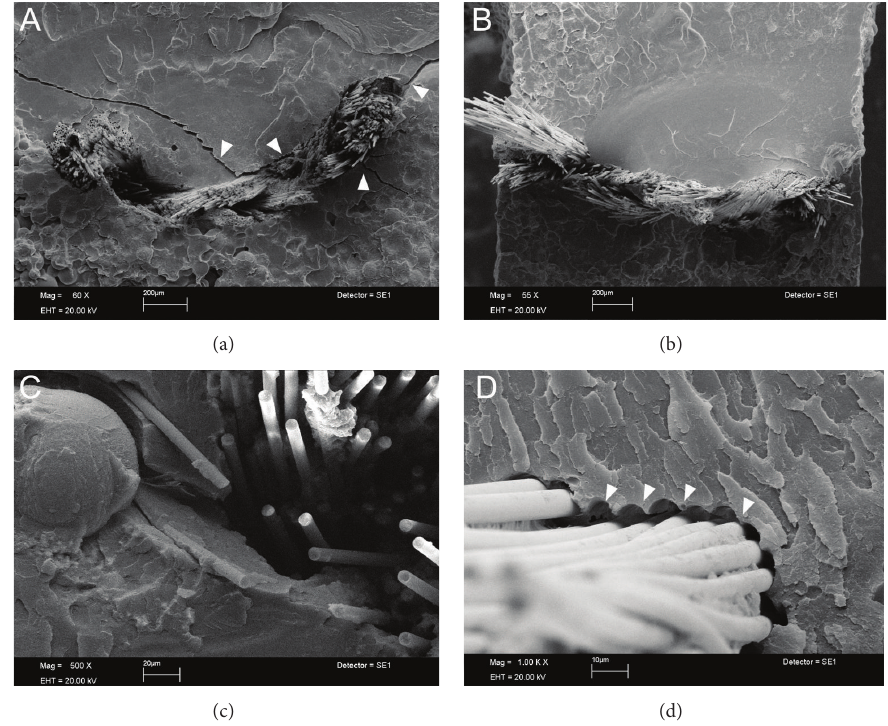
Figure 1: Woven glass preimpregnated fibers in industrialized glass fiber groups. (a) With self-polymerized resin ( × 60 magnification). Spaces between fibers and resin are due to failure of chemical and micromechanical interaction resulting in stress concentration regions with crack development (see arrows). (b) Micromechanical interlocking with heat-polymerized resin ( × 55 magnification). Note closer relationship between fibers and resin. (c) Presence of spaces between fiber and SP groups ( × 500 magnification). (d) Signals of spaces created after failure of micromechanical interlocking with HP ( × 1,000